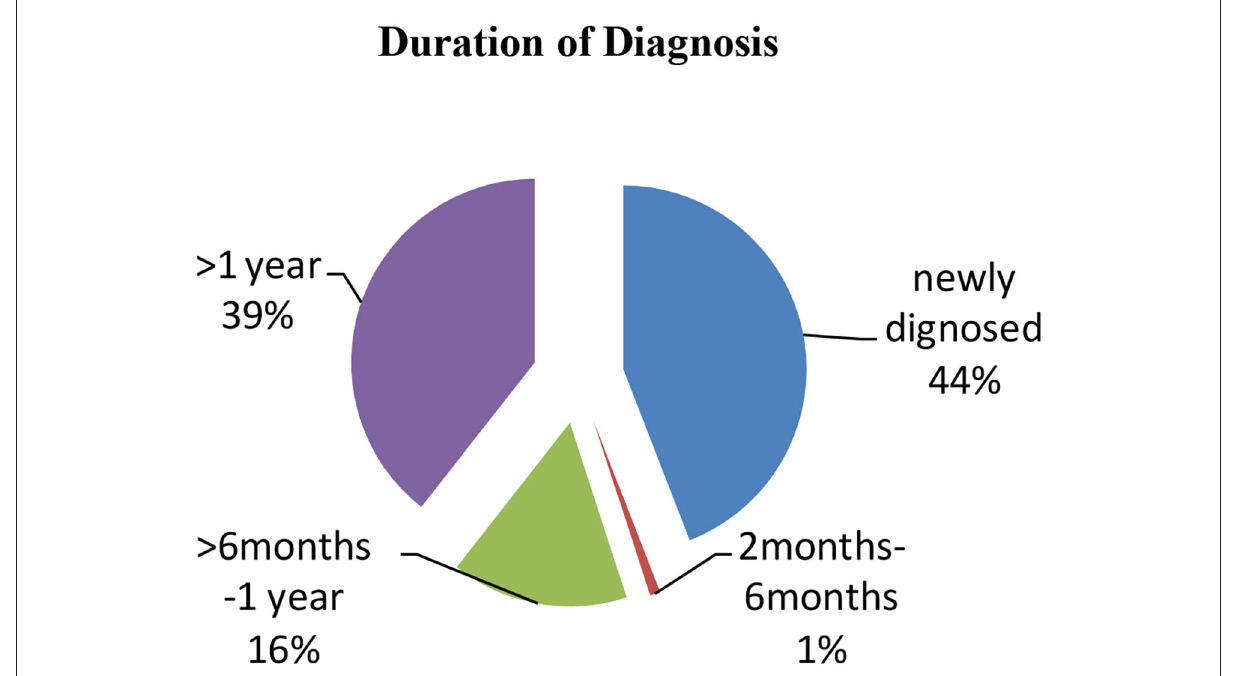
FIGURE2 Distribution of patients with celiac disease (CD) according to the duration of diagnosis.